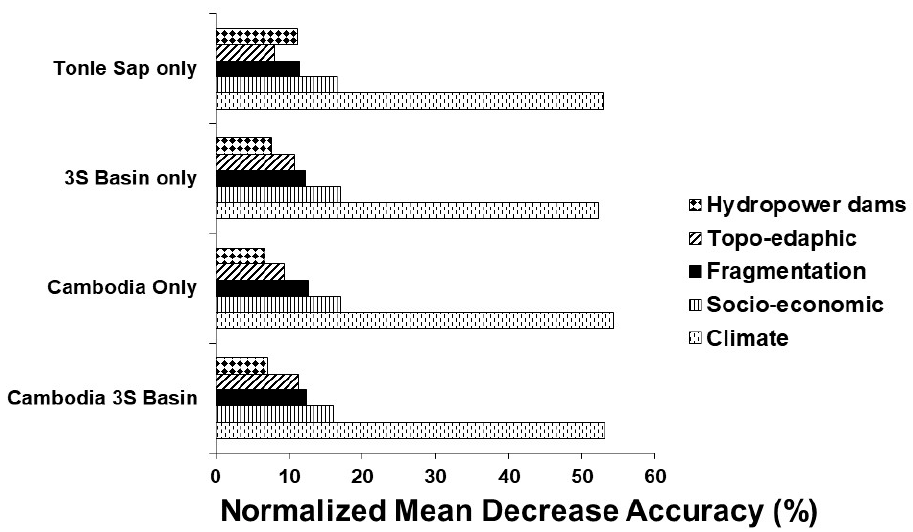
Figure 6. Drivers of deforestation in the Cambodia 3S Basin, Cambodia-only, 3S-Basin-only, and Tonle-Sap-only models.